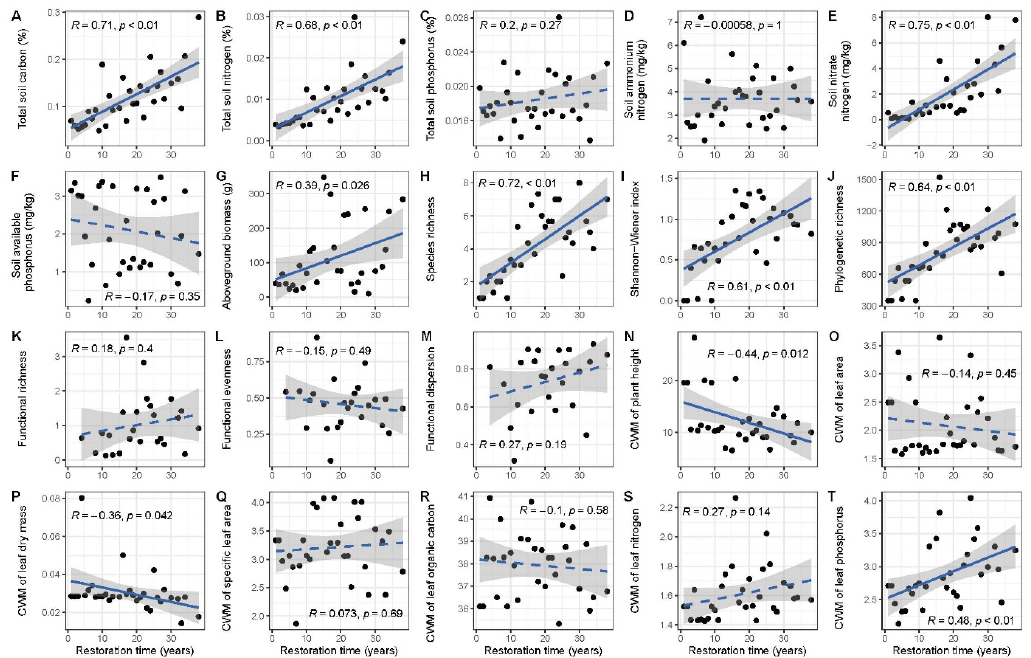
Figure 3. The correlation relationship between indexes in each criterion layer and restoration time. ( A – T ) Blue solid and dashed lines indicate significant and nonsignificant results of correlation, respectively, with grey shaded areas indicating the 95% confidence interval. Black filled circles are the value of the field sites. CWM indicate the Community-Weighted Mean Trait Values in N-T. 3.3. The Response of indices in Each Criterion Layer to the Restoration Time There are 20 indices in the CVOR model. Ten indices show a correlation with resto- ration time, and three indices (TC, TN, NH 4+ ) in the condition criterion layer show a pos- itive correlation with restoration time (Figure 3A,B,E). The aboveground biomass in the vitality criterion layer positively correlates with restoration time (Figure 3G). Three indi- ces (S, H ′ , P) in the organization criterion layer show a positive correlation with restora- tion time (Figure 3H,I,J). Among the seven indices in the resilience criterion layer, one of them (CWM LP ) is positively correlated with restoration time (Figure 3T), and two of them (CWM H and CWM LDM ) are negatively correlated with recovery restoration (Figure 3N,P). 3.4. The Response of Grassland Ecosystem Health to the Restoration Time The grassland ecosystem health (value of CVOR) shows an increasing trend with the recovery years (Figure 4). Most sites are in the cautionary hierarchy, accounting for 40.0% of all sites. Furthermore, 33.3% are in the unhealthy hierarchy, and 16.7% are in the col- lapse hierarchy. The smallest proportion is the healthy hierarchy, accounting for 10.0% of all sites.